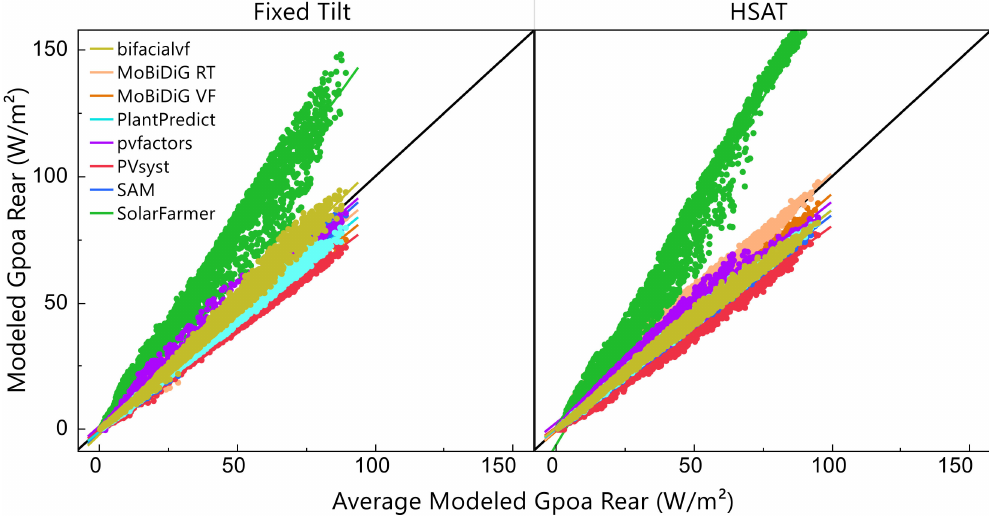
Figure 5. Simulated rear plane of array irradiance as a function of the average of the eight simulation tools. The solid black line is unity to the